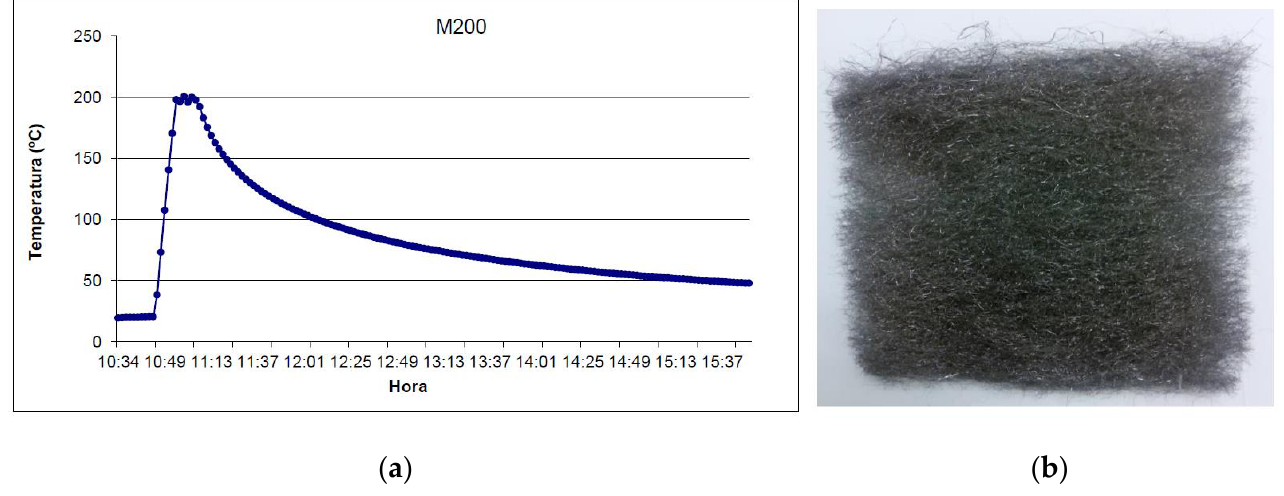
Figure 10. ( a ) Temperature-time process for the test at 200 °C and ( b ) sample after the testing.